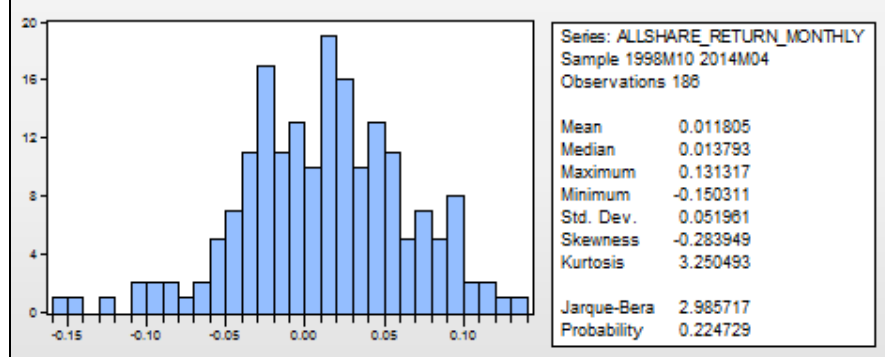
FIGURE 1: Descriptive Statistics of JSE Returns Source: